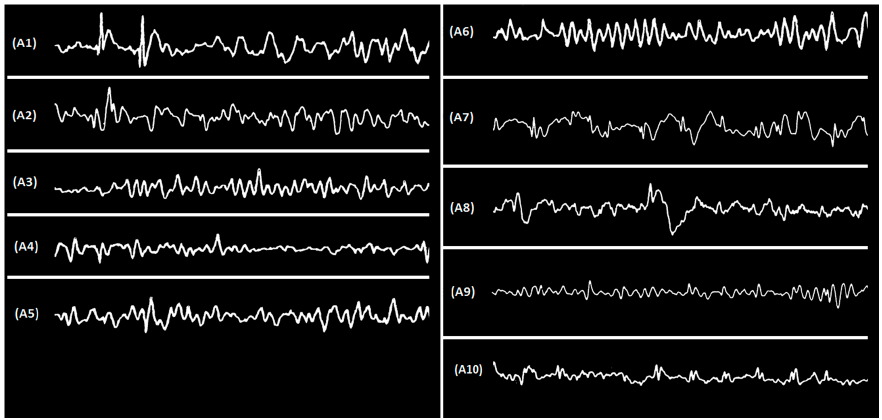
Figure 5. The chaotic electroencephalogram (EEG) time series that was included in the study for prediction applications.